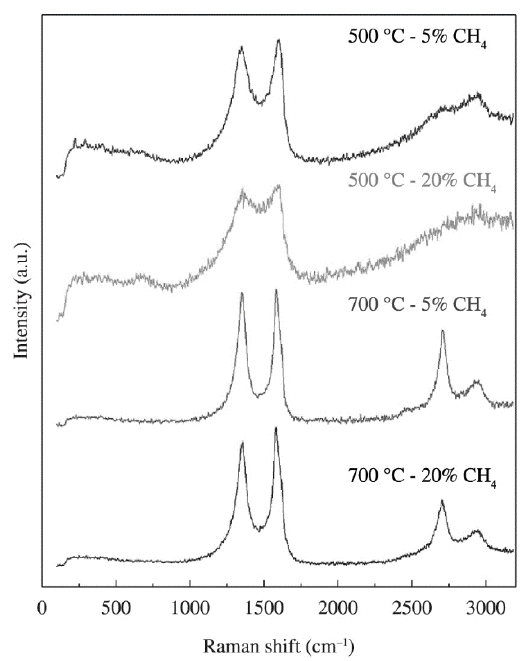
Figure 4. Raman spectra of the samples plasma carburized for 3 hours at 500 and 700